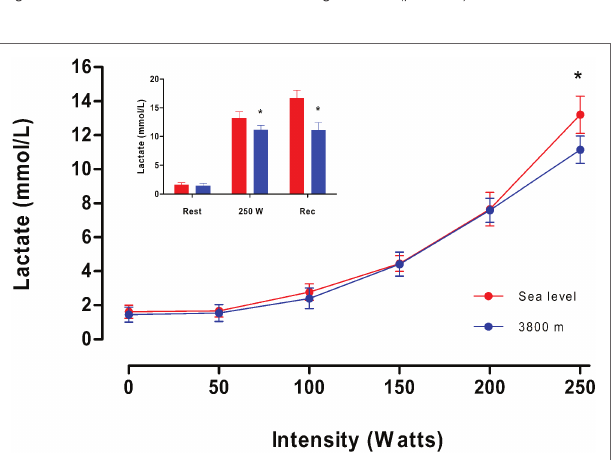
Values expressed as mean ± SD. *A significant difference between rest and maximum. † Significant difference between sea level and high altitude (p <